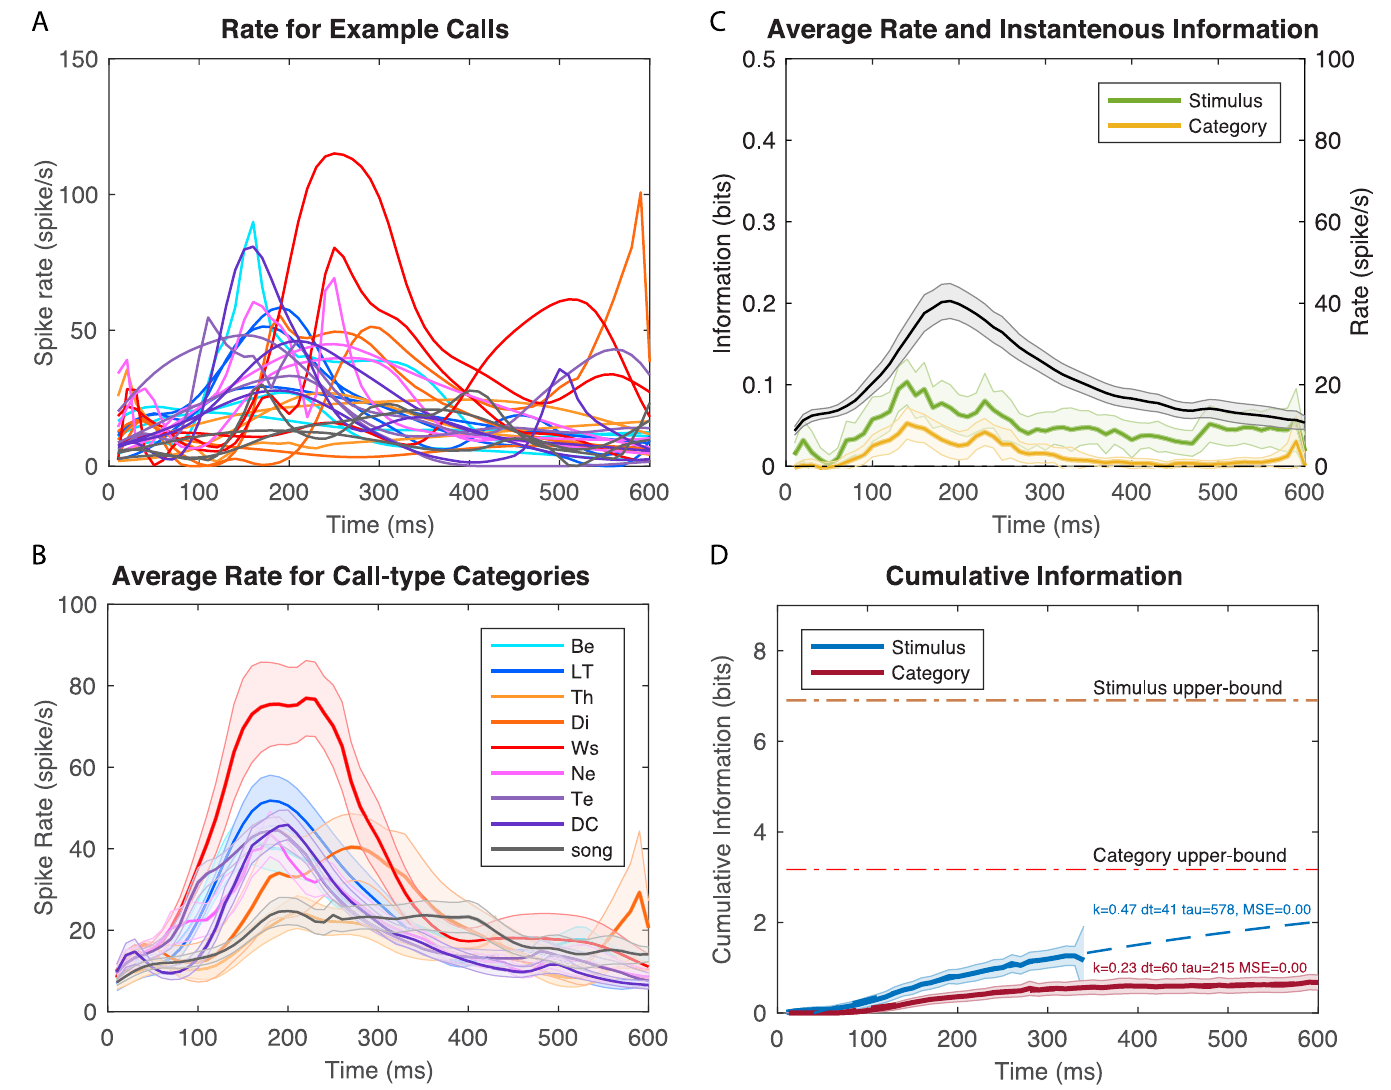
Fig 5. Time-varying firing rates and information values for example neuron 3. As in Fig 3 but for a neuron with intermediate firing rates and displaying selectivity for Wsst (Ws) or Aggressive Calls. Note also the longer latency relative to the neuron shown in 3 and 4. Spike rasters for this neuron are shown on S6 Fig. A . Time-varying firing rate obtained from KDE of ten repetitions of different example stimuli. B . Averaged time-varying firing rate obtained for each call-type category. C . Overall time- varying firing rate and instantaneous information for stimuli and call-type categories. D . Cumulative information for stimuli and call-type categories. See details in legend of Fig